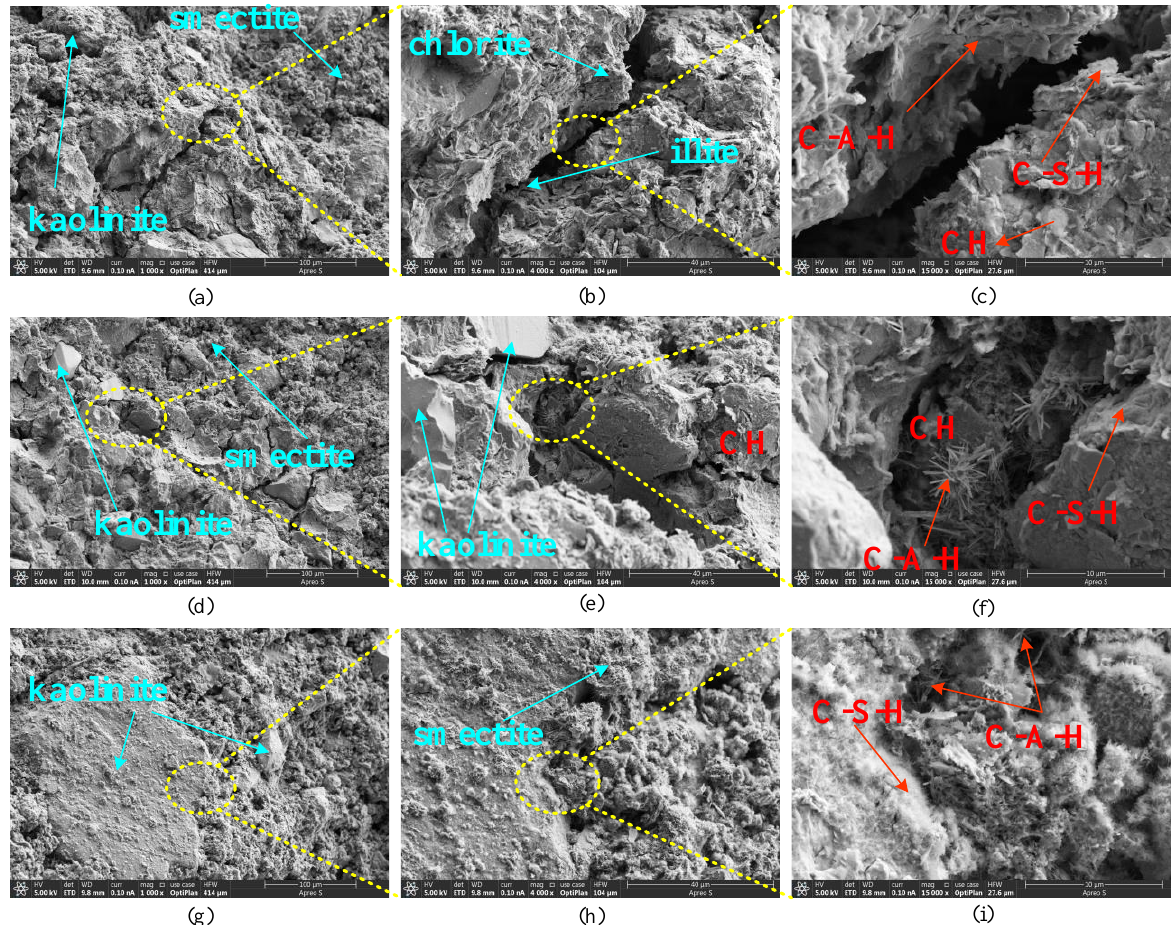
Figure 10. SEM of the test specimen. ( a ) The crack is magnified 1000 times; ( b ) The crack is magnified 4000 times; ( c ) The crack is magnified 15000 times; ( d ) The pore is magnified 1000 times; ( e ) The pore is magnified 4000 times; ( f ) The pore is magnified 15000 times; ( g ) The transition zone of interface are magnified 1000 times; ( h ) The transition zone of interface are magnified 4000 times; ( i ) The transition zone of interface are magnified 15000 times.